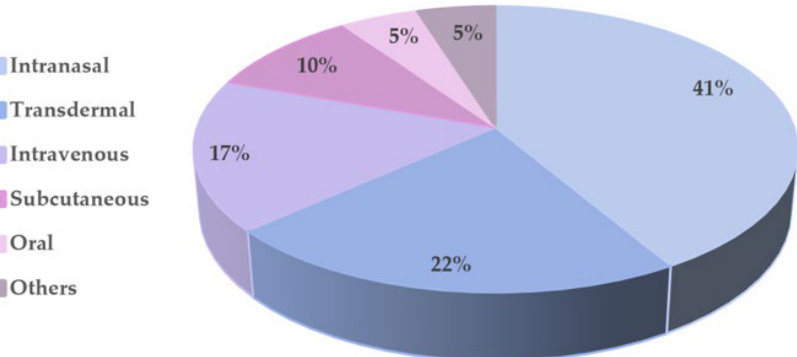
Figure 10. Schematic distribution of the developed DDS as a strategy to improve the efficacy of FDA-approved Alzheimer’s drugs by their administration routes. The graph was created based on the works reported in this review.